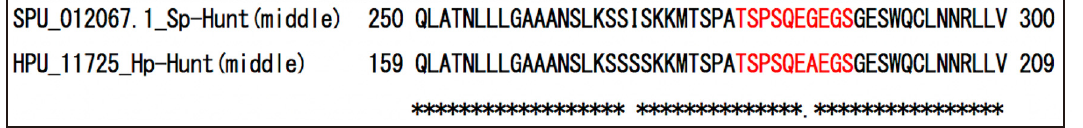
Figure 7. The antigen peptide sequence (red letters) and its location in the Sp-Htt protein (SPU_012067.1_Sp-Hunt: https://www.echinobase.org/entry/; Hp-Htt (HPU_11725_Hp-Hunt: HpBase: http://cell-innovation.nig.ac.jp/Hpul/ [48] (Access on 5 May 2021).The respective sequence is located in the middle section of the protein, and is very similar.